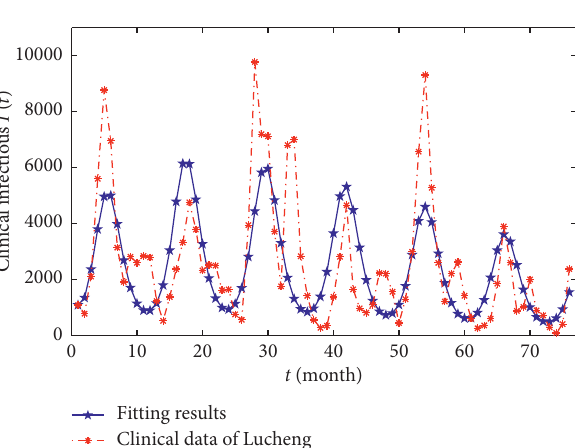
ρ ∈ [ 0 , 0 . 5 ] 0.1843 0.1733